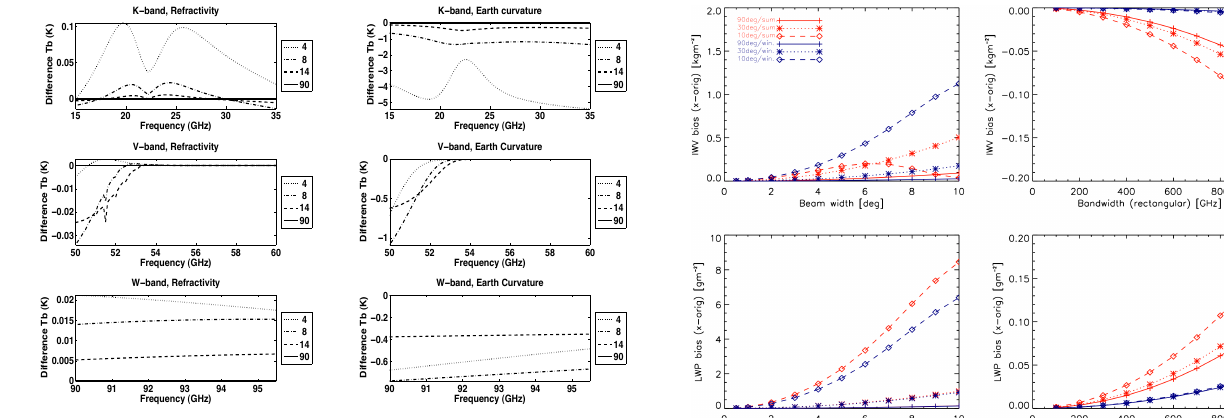
Fig. 17. The errors in TB associate to the refractivity effect on the left column and the Earth curvature effect on the right column at all frequencies for the mid-latitude summer profile in TB differences. The top plots show the results for K-band, the middle ones are V-band, and the bottom ones are W-band. In all plots, the dashed line is 4 ◦ elevation, dotted line is 8 ◦ , dash dot line is 14 ◦ , and the full line is 90 ◦ .